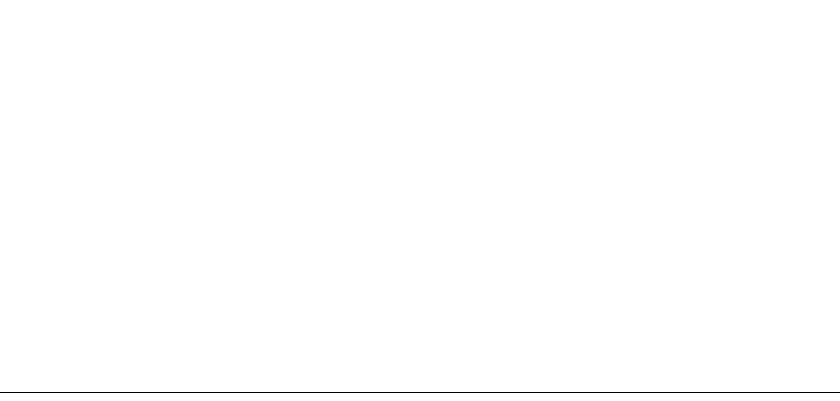
Frontiers in Genetics | Applied Genetic